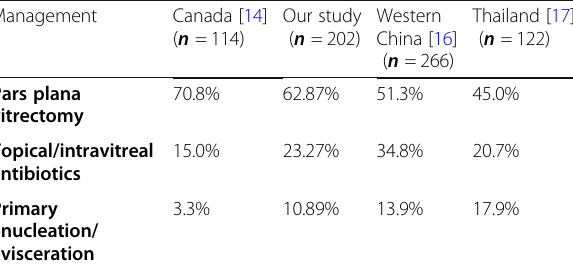
Table 11 Management of endophthalmitis cases compared to other studies. Our study showed a higher frequency of PPV and a lower frequency of primary enucleation and evisceration compared to other Asian countries